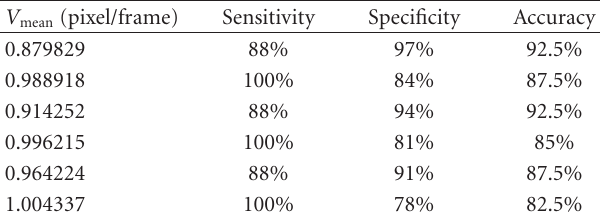
Table 1: List of top six value of mean potion vein flow for sensitivity and specificity in detection of Child-Pugh score A to